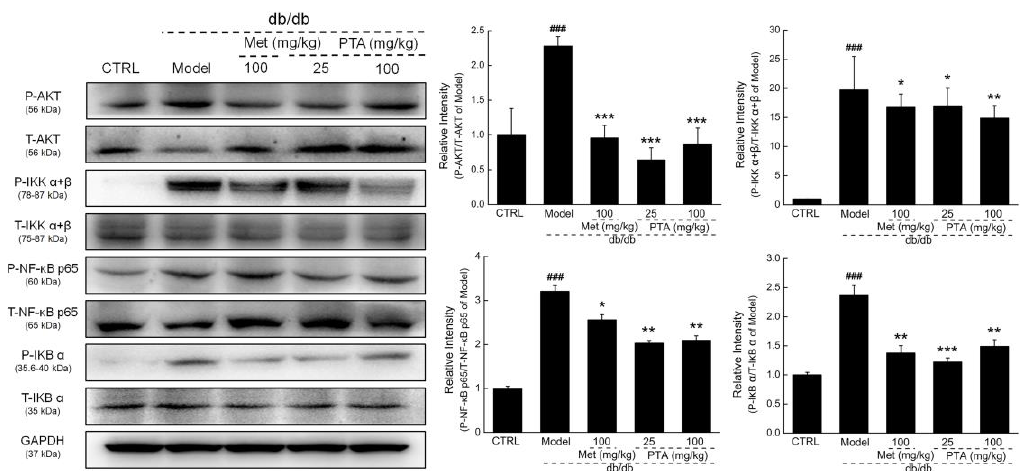
Figure 6. E ff ects of PTA on nuclear factor- κ B (NF- κ B) signaling in the kidneys of db / db mice. PTA Figure 6. Effects of PTA on nuclear factor- κB ( NF- κB ) signaling in the kidneys of db/db mice. PTA reduced the phosphorylation levels of protein kinase B (AKT), inhibitor of κ B kinase alpha + beta reduced the phosphorylation levels of protein kinase B (AKT), inhibitor of κB kinase alpha + beta (IKK α + β ), inhibitor of κ B alpha (I κ B α ) and NF- κ B p65 in the kidneys of db / db mice. Data are expressed ( IKKα+β ), inhibitor of κB alpha (IκBα ) and NF- κB p65 in the kidney s of db/db mice. Data are as means ± SD (n = 6). ### p < 0.001 vs. db / m + mice, * p < 0.05, ** p < 0.01 and *** p < 0.001 expressed as means ± SD (n = 6). ### p < 0.001 vs. db/m + mice, * p < 0.05, ** p < 0.01 and *** p < 0.001 vs. non-treated db/db mice.